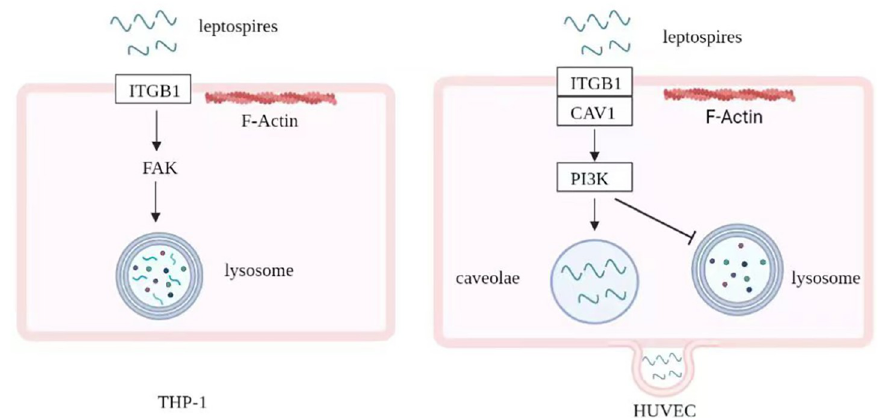
Fig 7. Graphical abstract of diverse internalization mechanisms of Leptospira interrogans in human macrophages and vascular endothelial cells.